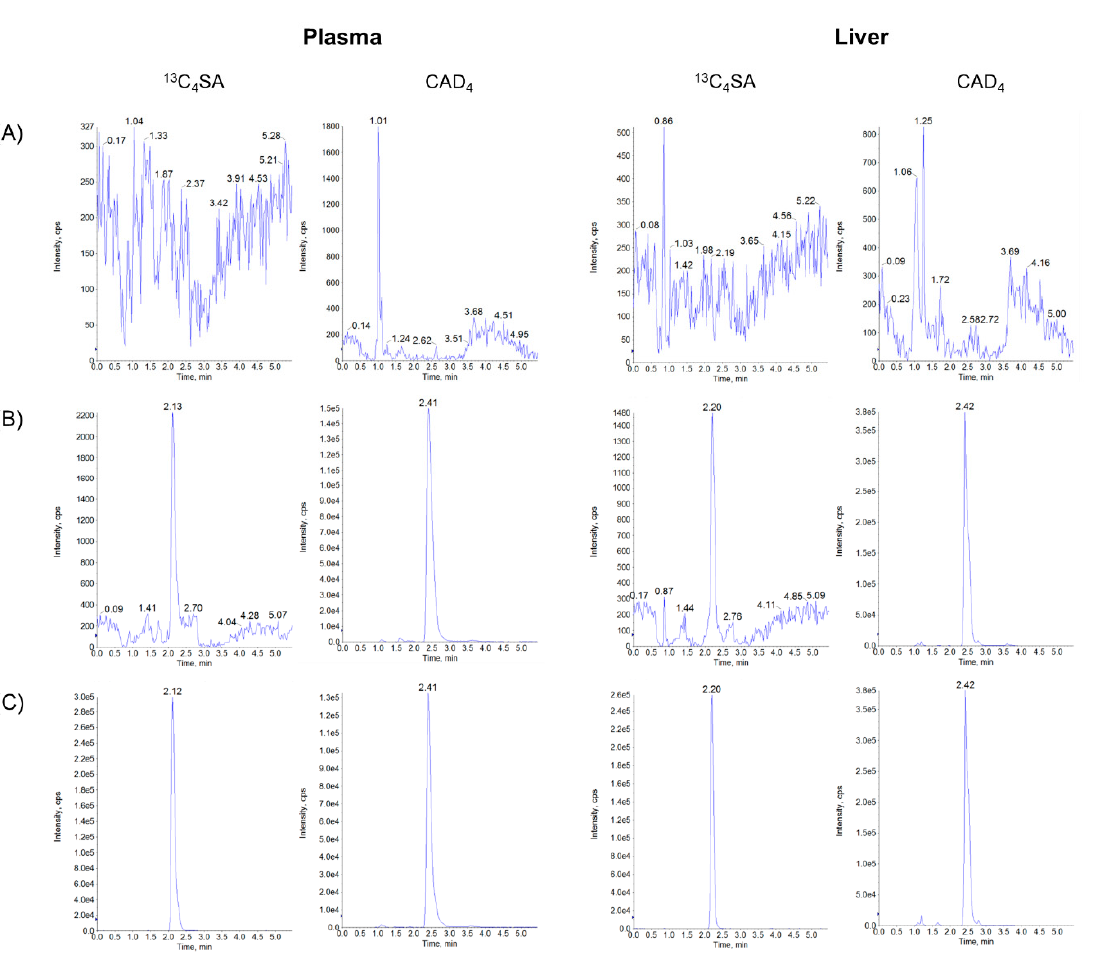
Figure 1. UHPLC-MS/MS chromatograms of 13 C 4 SA and CAD 4 in plasma and liver samples: ( A ) blank matrix, ( B ) LLOQ concentration of spiked blank matrices with IS, and ( C ) samples (plasma and liver 15 min after PO administration of 100 mg/kg 13 C 4 SA).